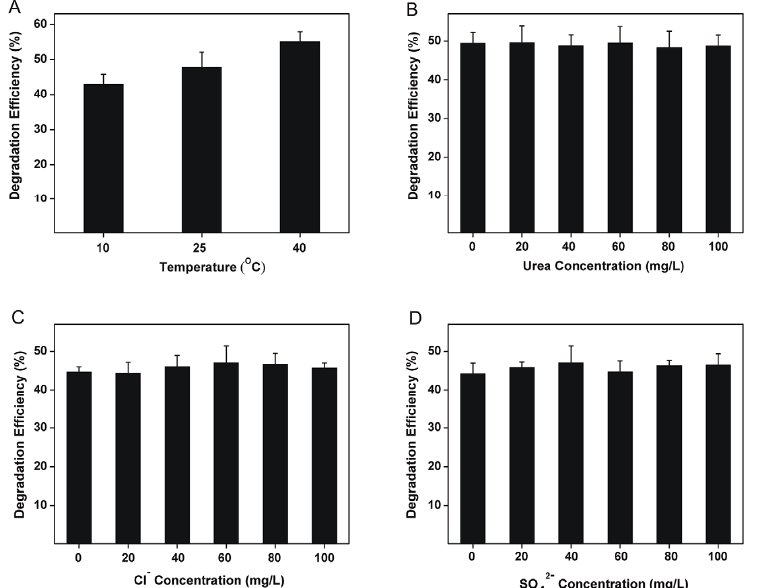
Figure 4. DE of SSM (0.6 g/L) on CTC in aqueous solution (pH = 5, 20 mg/L) under different condi- tions: ( A ) different temperature; ( B – D ) coexistence of urea, Cl − , and SO 42 − .